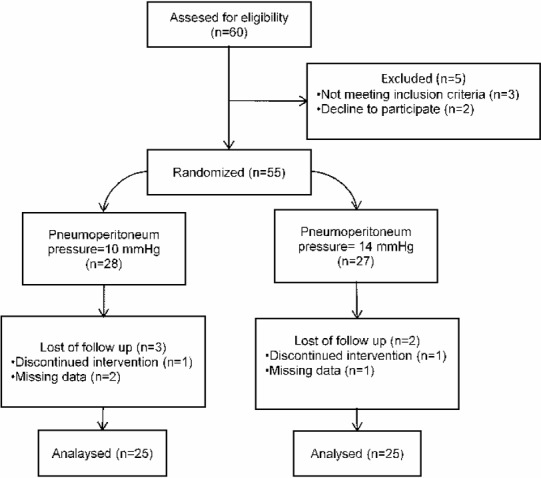
Flowchart diagram of the study.